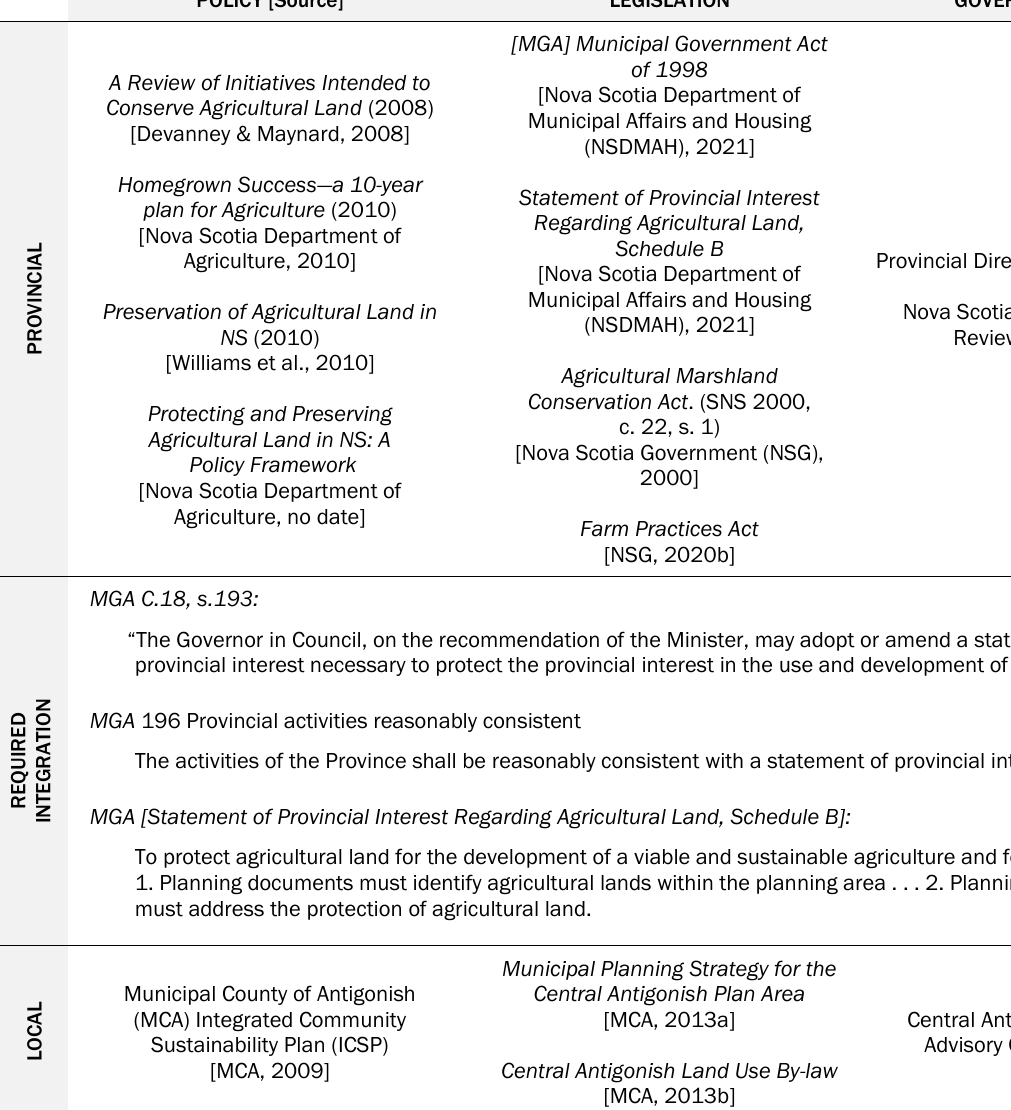
Table 1. Legislative Framework for Nova Scotia and the Municipal County of Antigonish POLICY